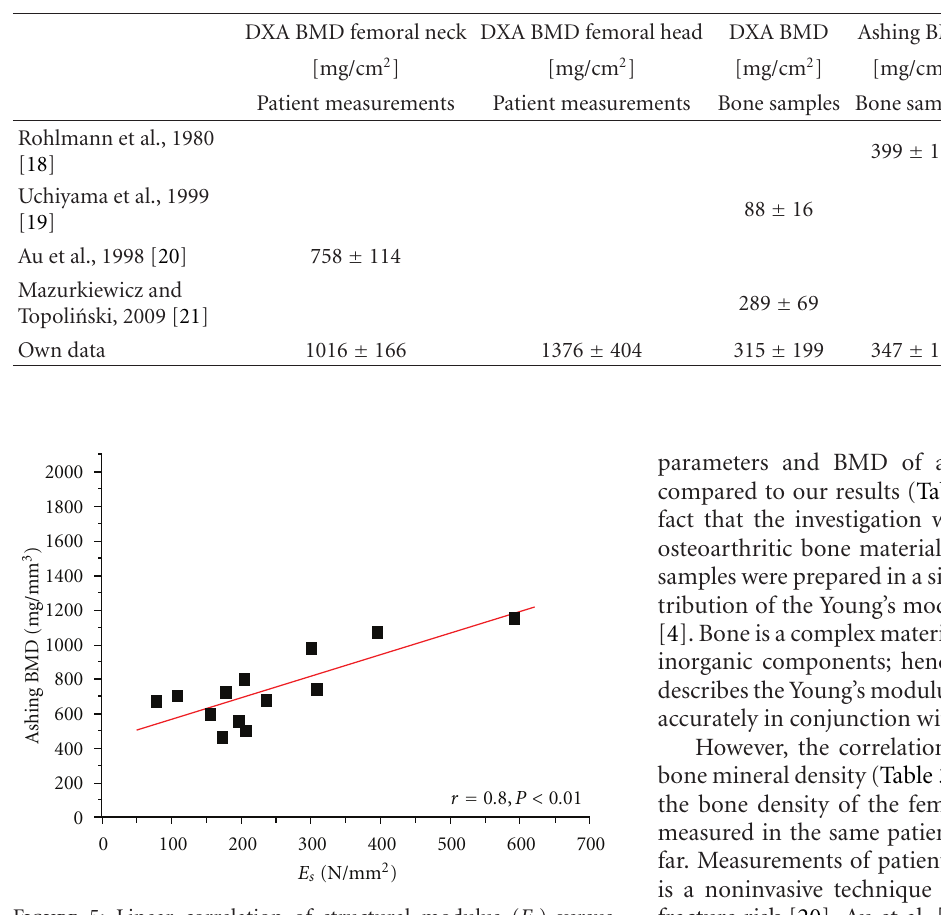
Figure 5: Linear correlation of structural modulus ( E s ) versus ashing BMD (on bone